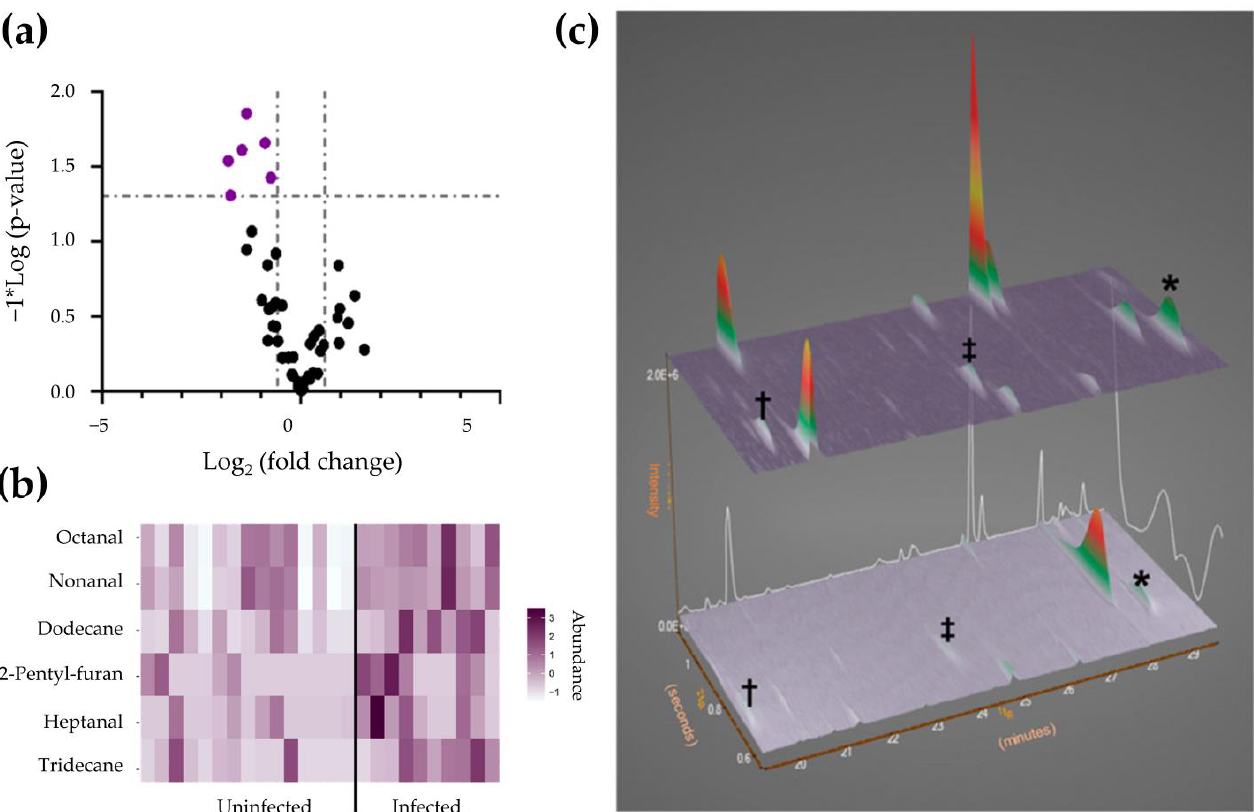
Figure 4. Biomarker compounds of pediatric SARS-CoV-2 infection. ( a ) Volcano plot of breath metabolites. ( b ) Heatmap visualizing the abundance of biomarkers. ( c ) GC × GC–TOFMS surface plots of representative pediatric breath samples (top, SARS-CoV-2 infected; bottom, SARS-CoV-2 uninfected; †, heptanal; ‡, octanal; *, nonanal). Adapted with permission from Ref. [150]. Copyright © 2023 by the authors; American Chemical Society, Washington, DC, United States.